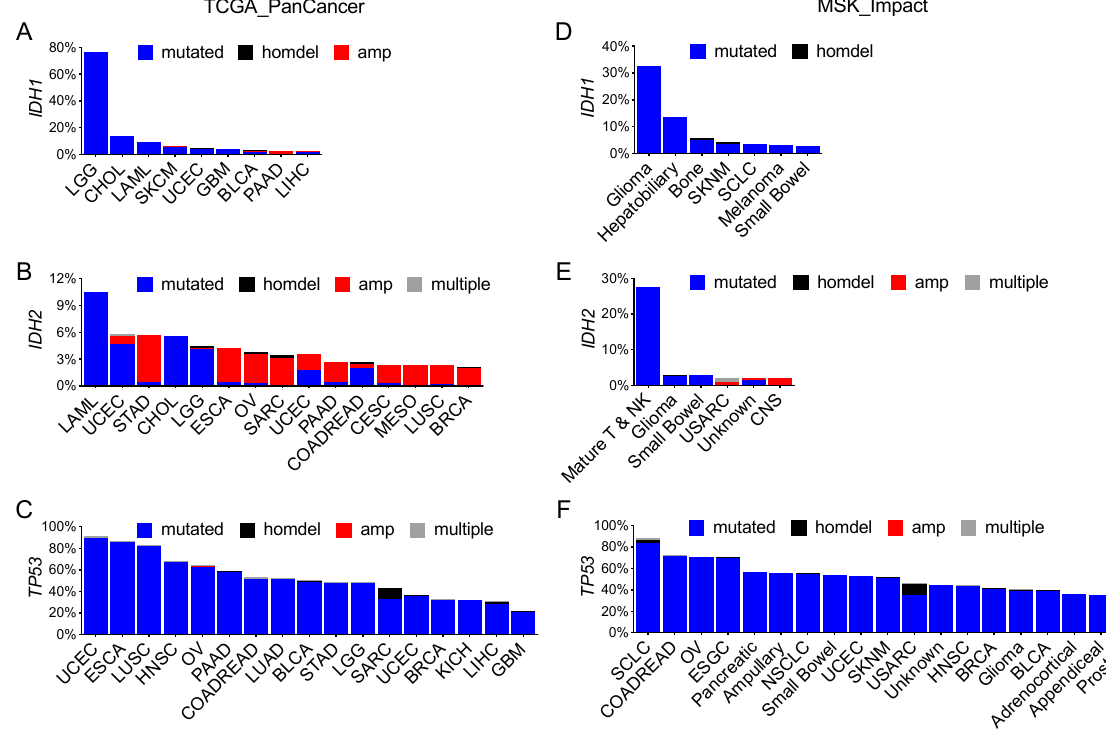
Figure 2. Distinctive distribution of IDH1 , IDH2 , and TP53 alterations in human cancer. Extraction of IDH1 , IDH2 , and TP53 alterations from specified datasets revealed a high frequency of IDH1 mutations exclusively in glioma ( A , D ). Whereas relatively high frequencies of IDH2 mutation were limited to hematopoietic neoplasms, IDH2 amplification (amp) was seen in more cancer types ( B , E ) and TP53 alteration was widespread ( C , F ). The cutoff is 2% for IDH1 and IDH2 and 20% ( C ) or 30% ( F ) for TP53 .